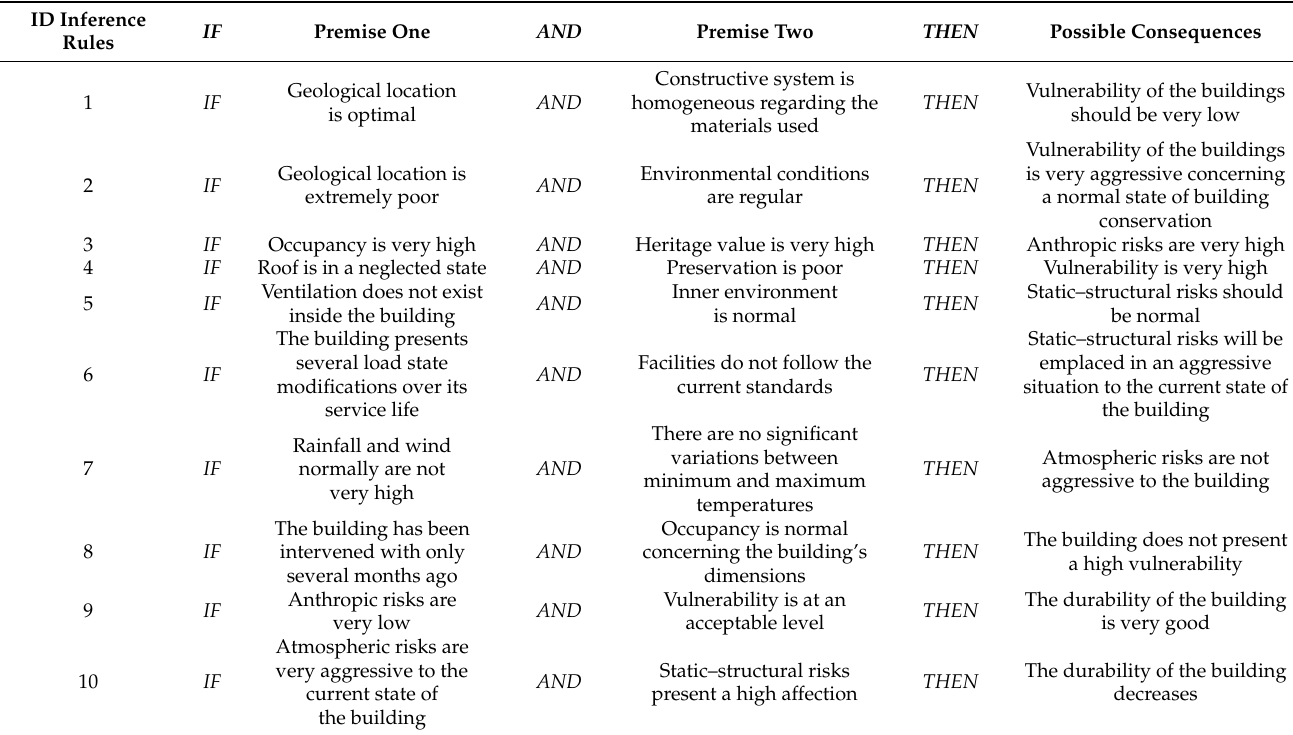
Table 5. IF–THEN fuzzy inference procedures and rules generated by professionals’ knowledge.